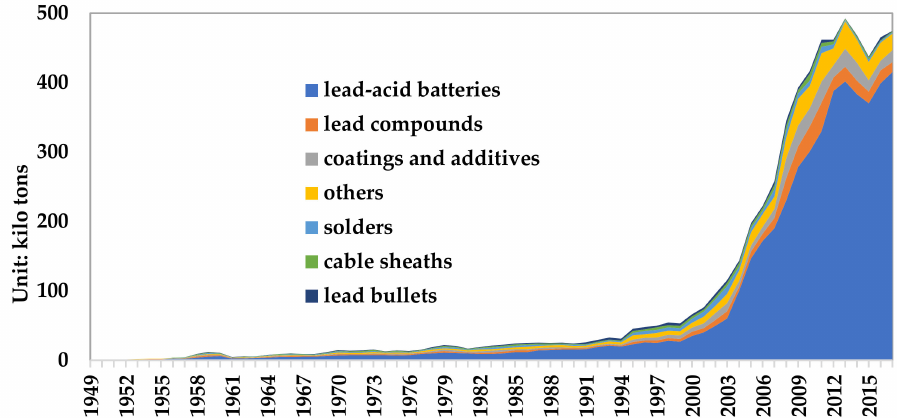
Figure 4. Consumption structure of refined lead from 1949 to 2017. (Data source: China Nonferrous Industry Association; Beijing Antaike Information Co., Ltd.).